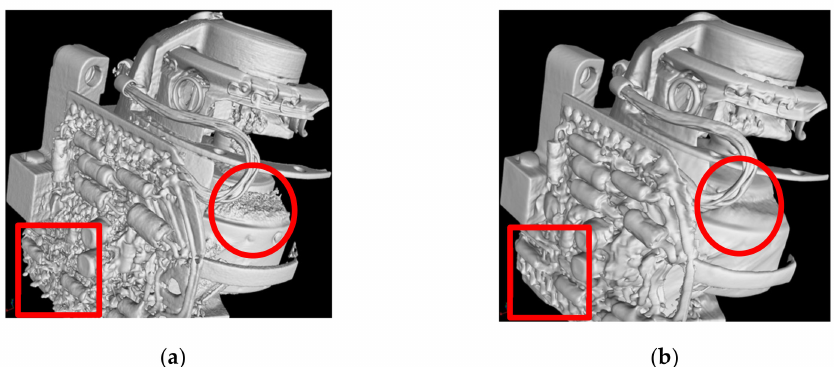
Figure 15. Comparison of two iso-surfaces calculated from the reconstructed volumes in the regions-